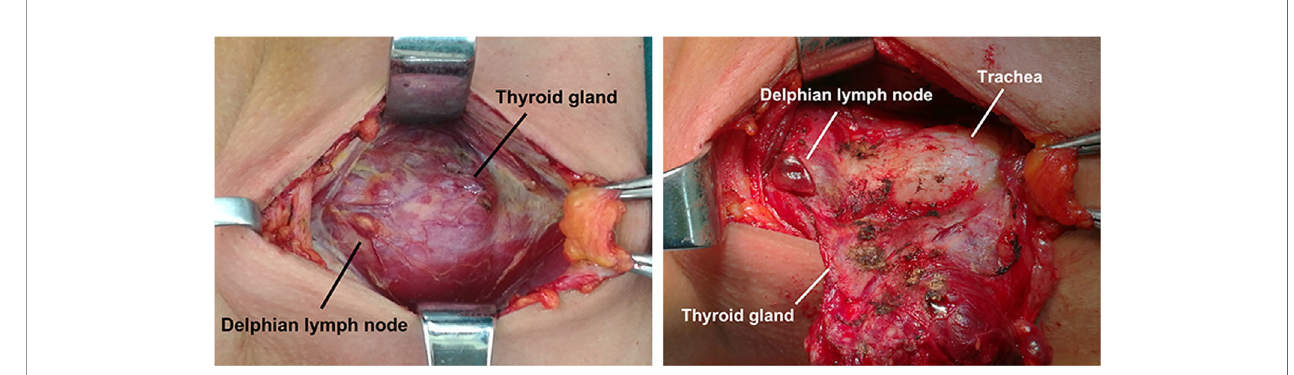
FIGURE 1 | The Delphian lymph node